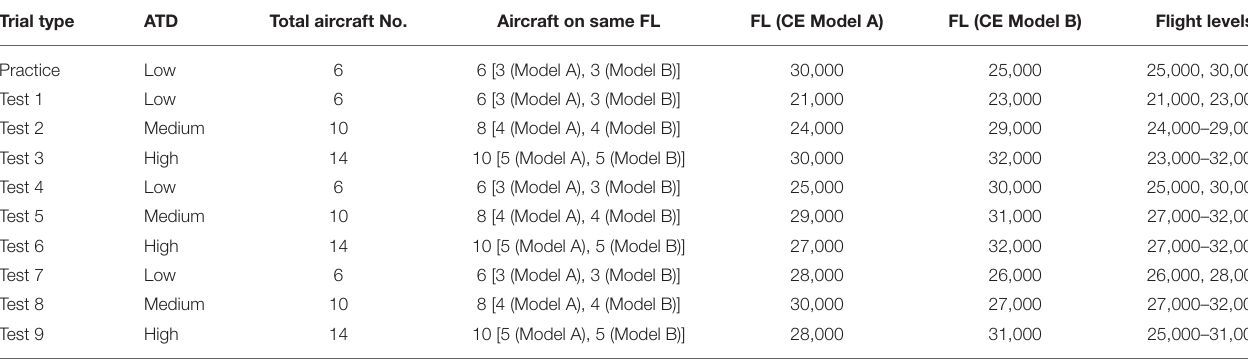
TABLE 1 | Flight Parameters used in Air Traffic Conflict Detection Task (AT-CDT) Practice and Test Simulation Trials. Trial